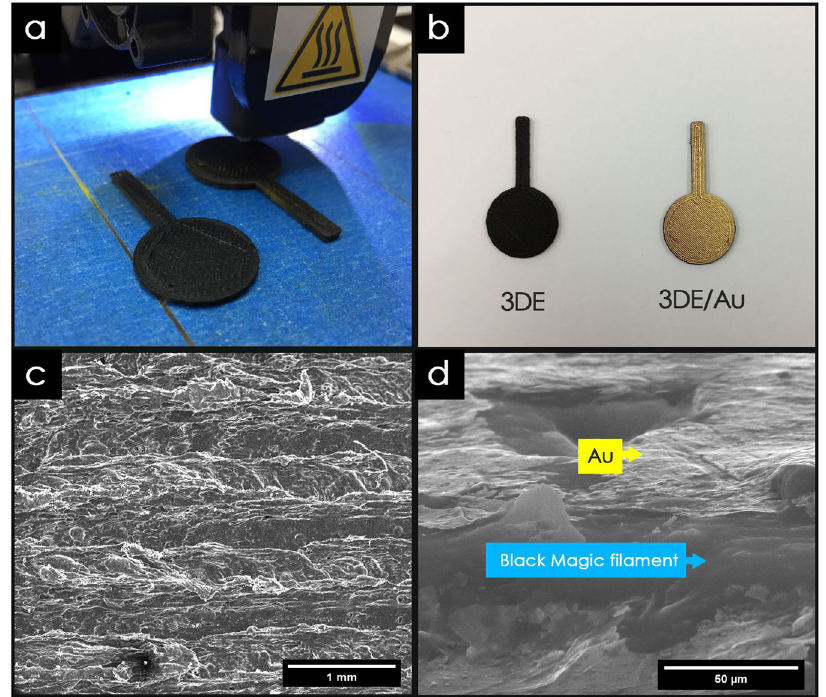
Figure 1. Physiochemical characterization. ( a ) Optical image of 3D printing process, ( b ) 3D printed electrode used throughout study. ( c ) FESEM image of 3DE/Au electrode, and ( d ) corresponding magnified cross- sectional